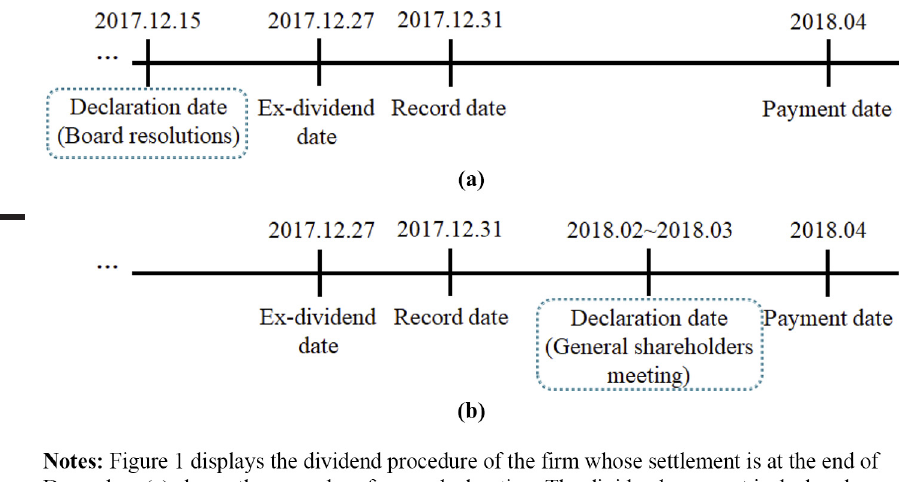
Figure 1. Dividend